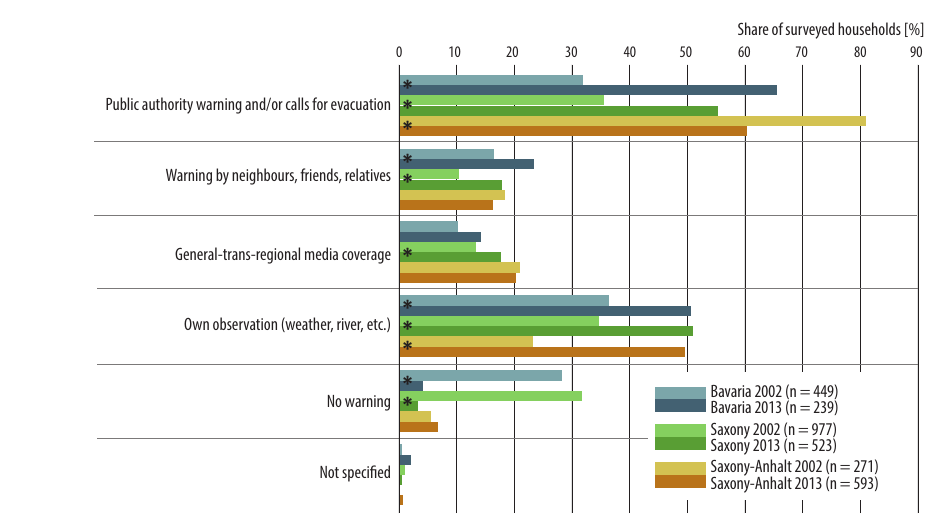
Figure 2. Answers of the interviewed private households in Bavaria, Saxony and Saxony-Anhalt in response to the question of how they became aware of the imminent flood danger ( ∗ indicates significant differences ( p <0.05) between 2002 and